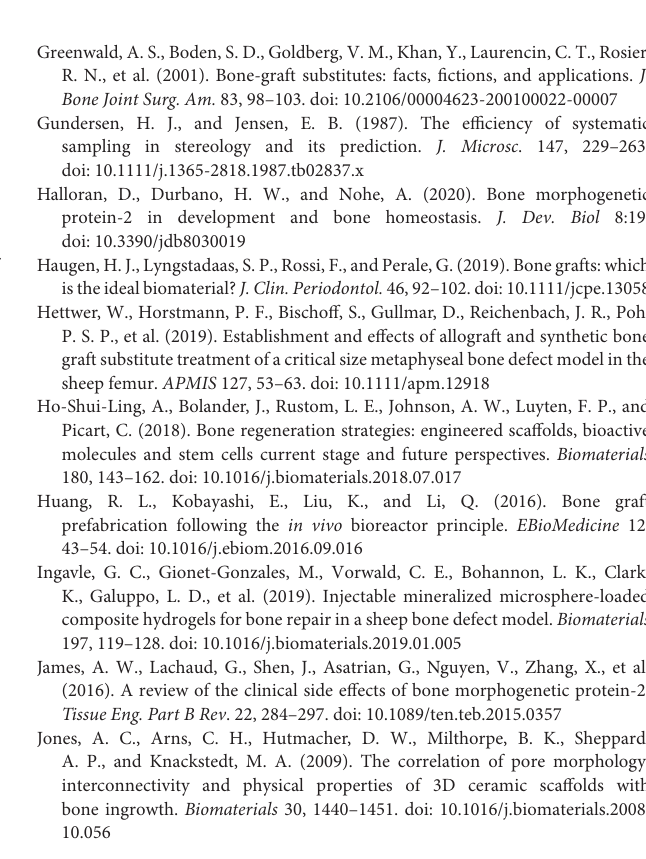
Supplementary Figure 1 | Histological images showing active bone regeneration process during 4 and 8 weeks of grafting in the BMP2-sur.BioCaP group. White star: newly formed bone; white triangle: remaining graft; black arrow: mononuclear immune cells; yellow arrow: chondrocytes and hypertrophic chondrocytes-like cells; green arrow: osteoblast lining cells. Supplementary Figure 2 | Histological images showing active multinucleated giant cells, bone marrow-like, and blood vessel-like structures. White star: newly formed bone; white triangle: remaining graft; black arrow: active osteoclasts; yellow arrow: chondrocytes and hypertrophic chondrocytes-like cells; green arrow: osteoblast lining cells; pink arrow: resorbed graft material by active osteoclasts; M: bone marrow-like structure; V: blood vessel-like structure. Supplementary Figure 3 | Quantitative analysis of volume density of blood vessels like structure (A) , and graft material degradation (%) (B) . Data are presented as mean ± SD ( n =